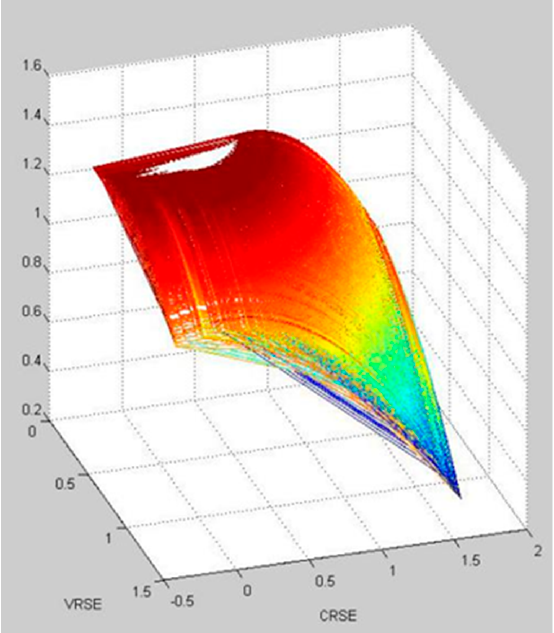
Figure 8. The visualization of simulation of the effect of Chinese outward FDI on wellbeing in Group 2.